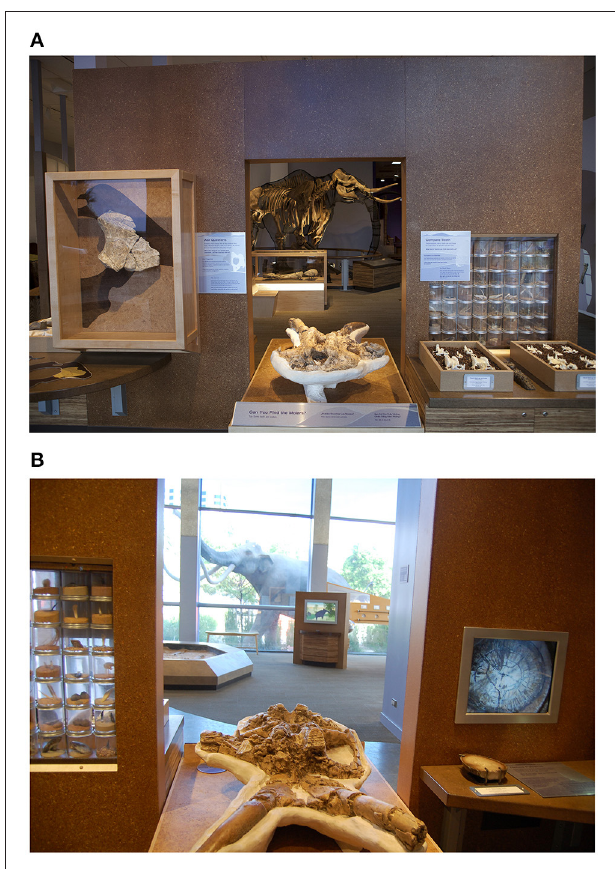
FIGURE 3 | (A) Sample bone exhibits: Authentic pelvis bone on wall on left; replica skull in lower center; full-scale mammoth skeleton and femur bone visible through opening. (B) Sample bone exhibits: Replica skull lower center; Full-scale mammoth replica outside window; dig pit through opening on lower left (spin browser visible right of dig pit).